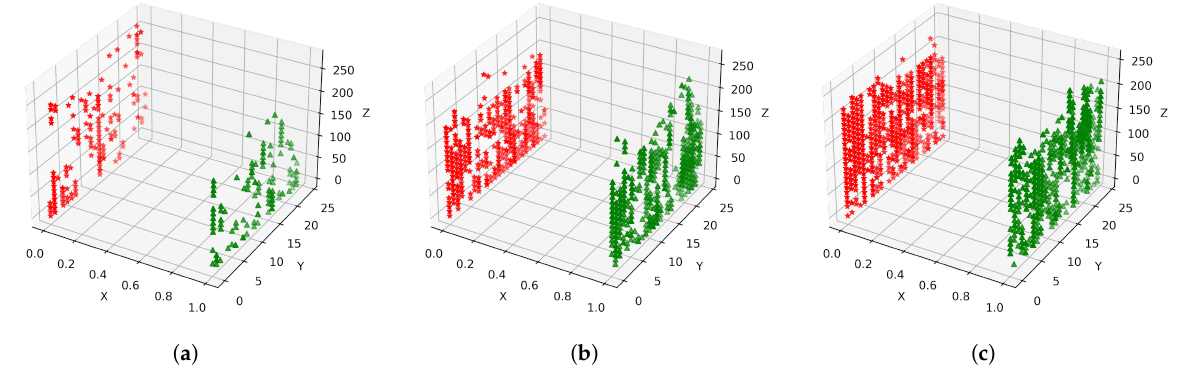
Figure 15. Distribution of tomatoes with blossom-end rot reported by the system. Red dots are the results of column x 0 ; green dots are the results of column x 1 . Darker dots indicate multiple diseased tomatoes. ( a ) Results on April 10; ( b ) results on May 12; ( c ) results on June